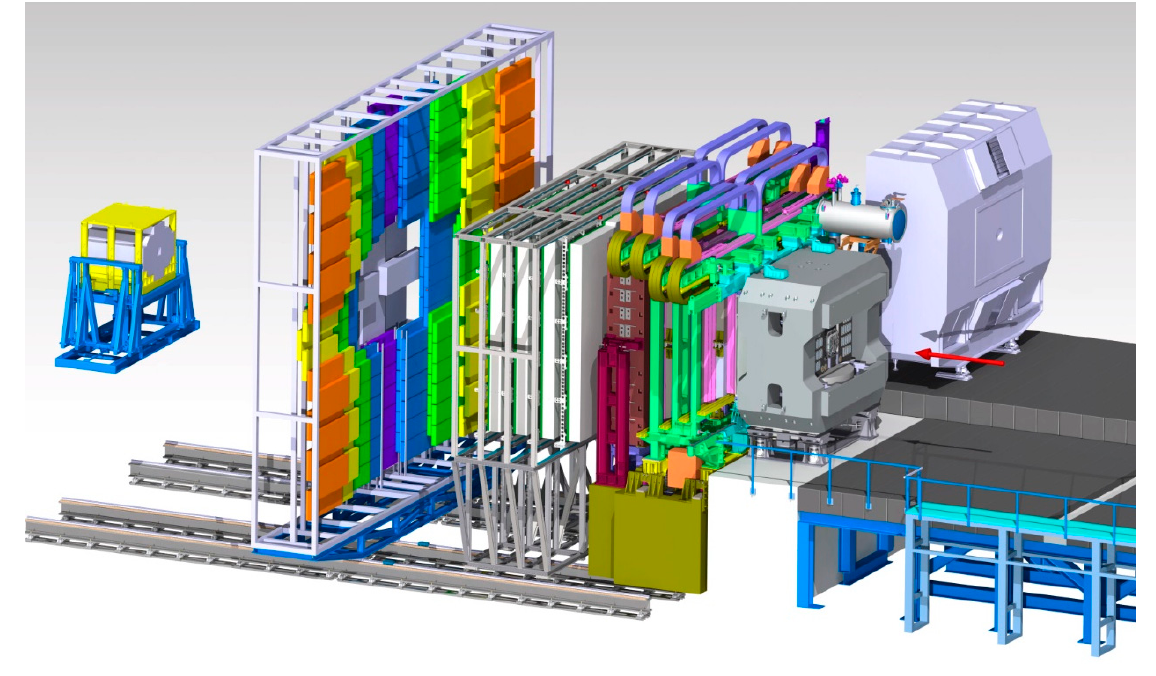
Figure 2. The CBM experimental setup at FAIR (see text). The beam enters from the right side.